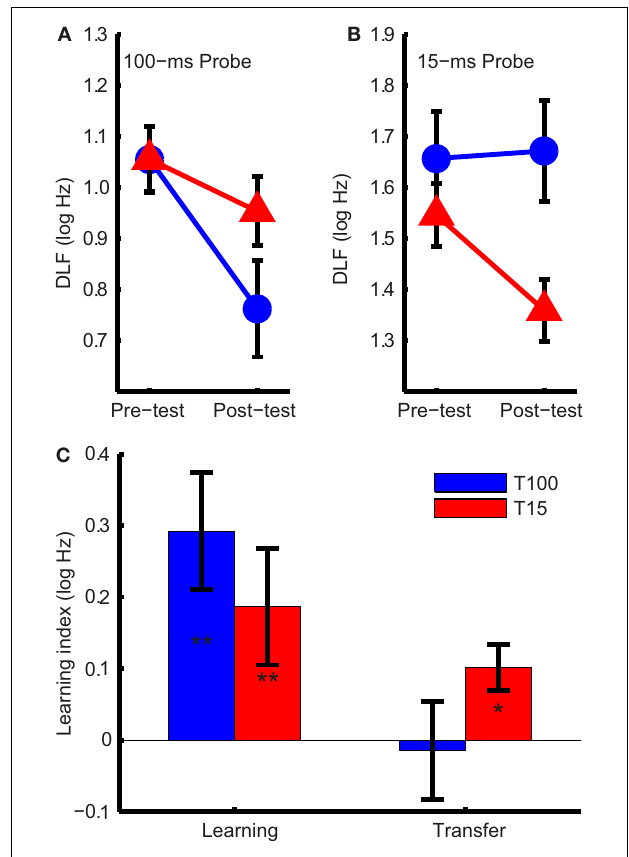
FIGURE 2 | Difference limens for frequency (DLFs) and learning indices. (A) Group mean DLFs for 100-ms and (B) 15-ms pre- and post-test probes in the 100-ms (T100, in blue) and 15-ms (T15, in red) training groups. Note that the scales in (A) and (B) are different. (C) Mean group learning indices (the difference between the pre- and post-test DLFs, in log Hz) for the trained and untrained condition. Significant changes are marked with asterisks (* p < 0.05; ** p < 0.01). Error bars indicate ± 1 SEM. across listeners.